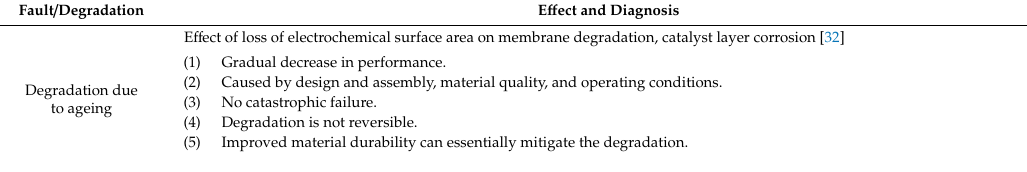
Table 1. Faults and their e ff ects on the operation of proton exchange membrane fuel cells